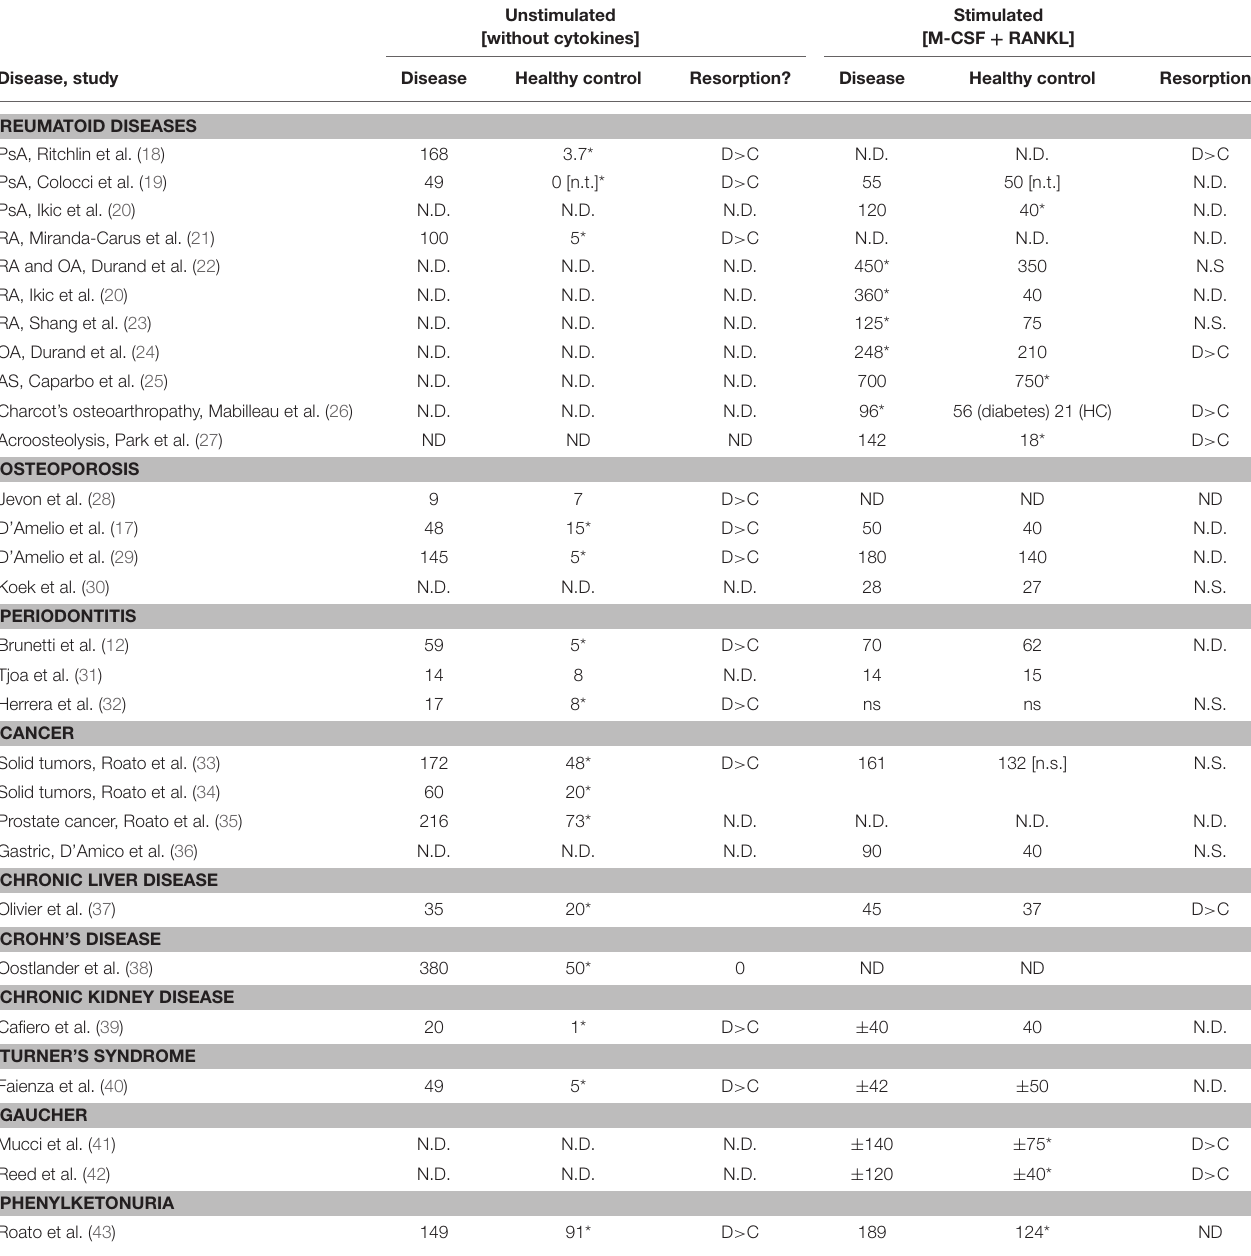
Unstimulated [without cytokines]